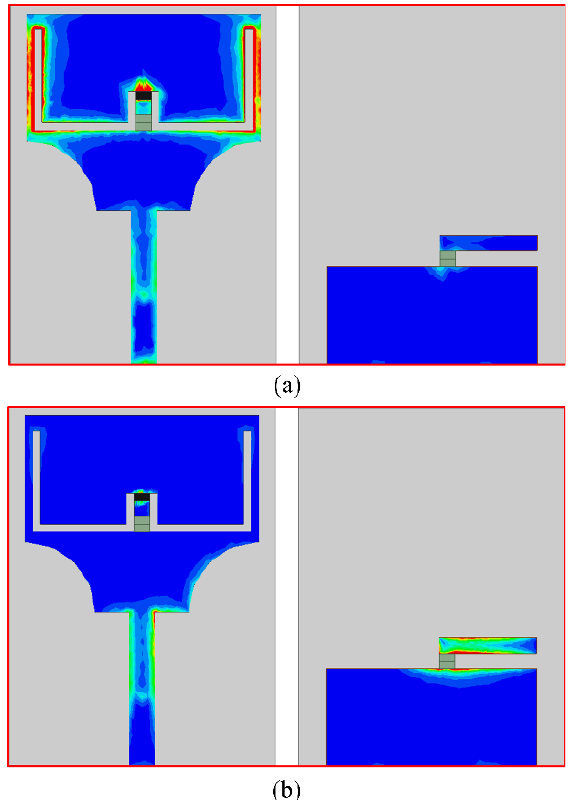
Figure 12. Surface current distribution of the proposed antenna for case-01 ( a ) 3.5 GHz; ( b ) 5.5 GHz.